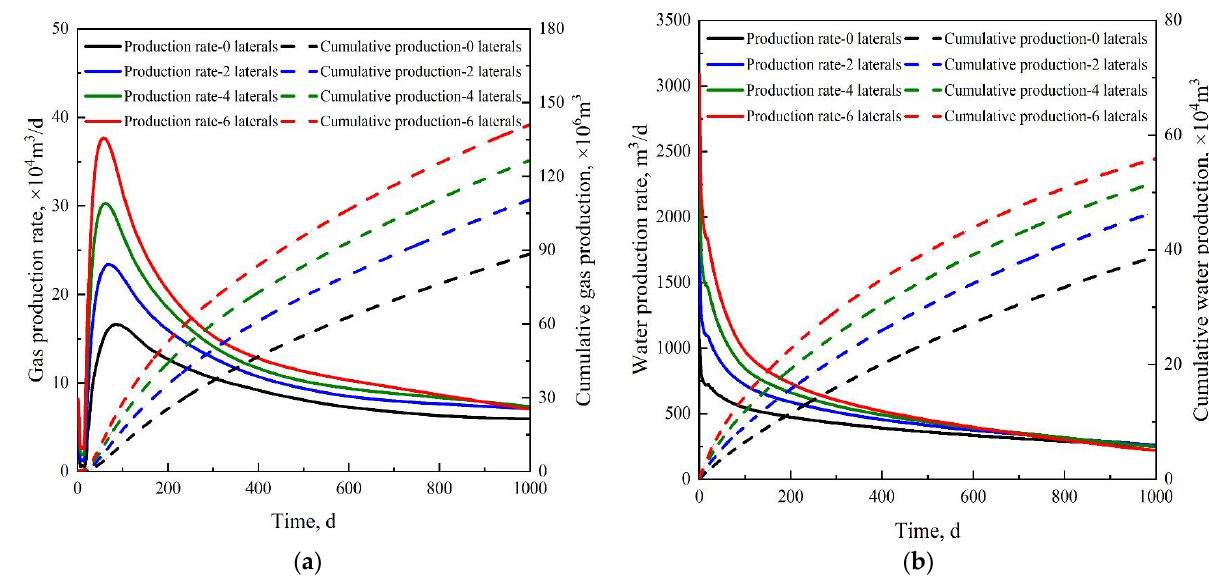
Figure 4. ( a ) Gas production, ( b ) water production. Production of fishbone well with different branches using